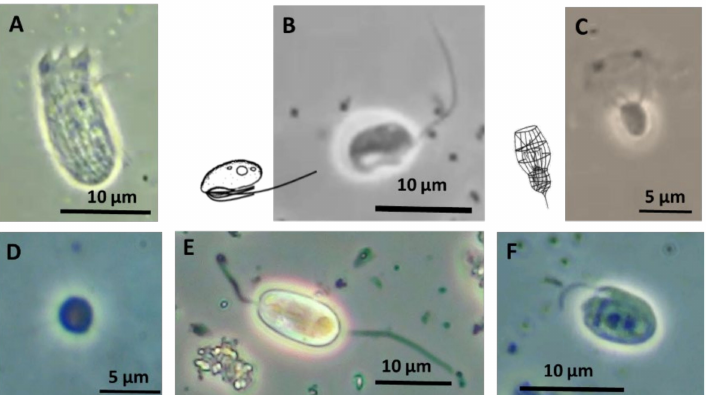
Figure 4. Examples of morphotypes detected in culture. ( A ) Stephanopogon sp. (Heterolobosea), ( B ) Percolomonas -like flagellate (Heterolobosea) ( C ) Stephanoeca -like flagellate (Choanoflagellata)